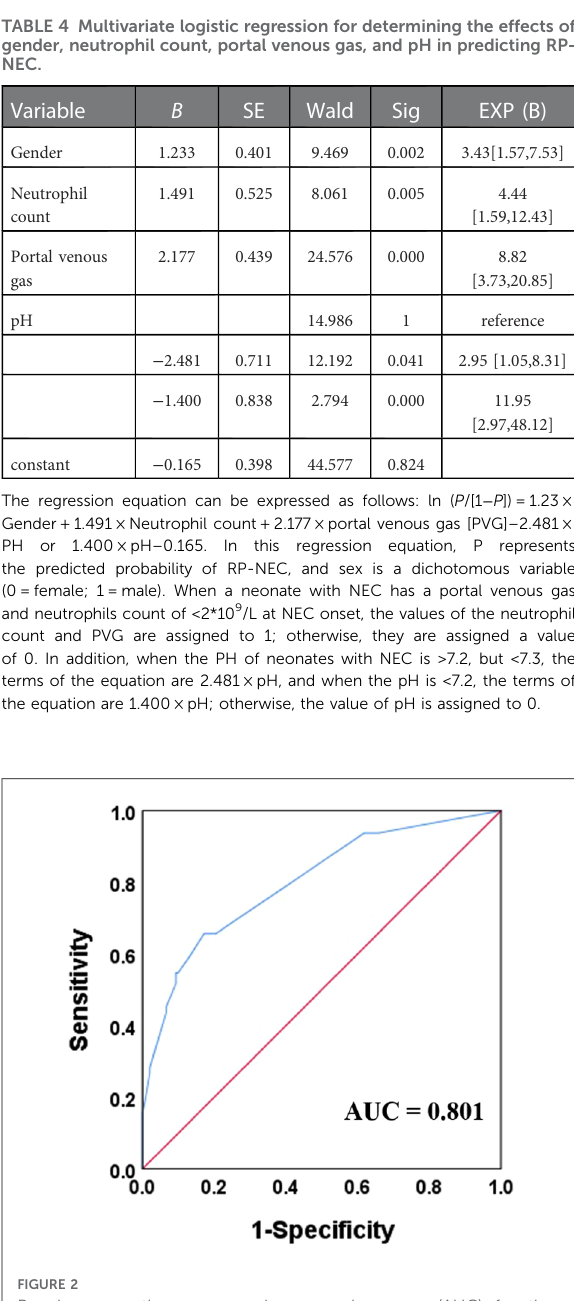
FIGURE 2 Receiver operation curve and area under curve (AUC) for